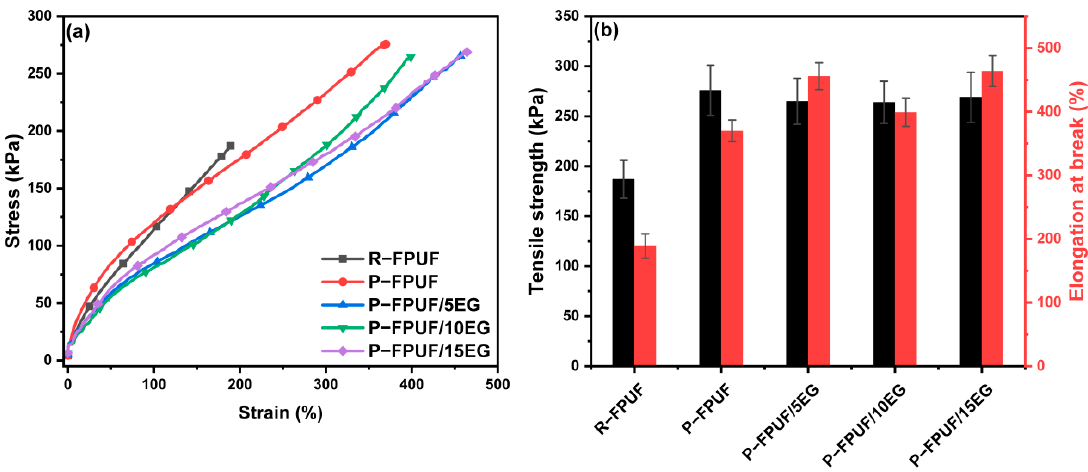
Figure 14. Mechanical properties of pure FPUF ( a ) and flame-retardant FPUFs ( b